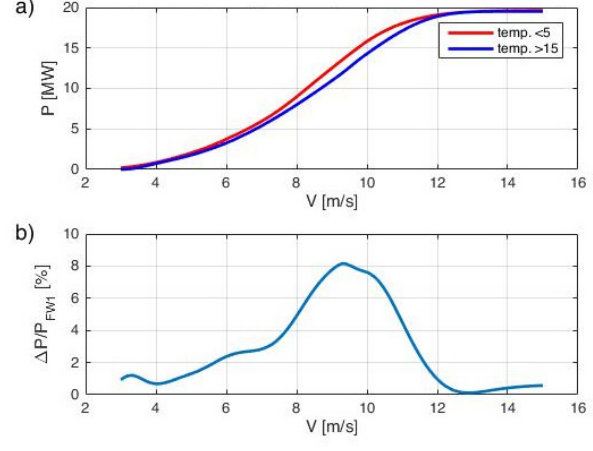
Figure 8. Wind power plant FW1: ( a ) power characteristics for T < 5 ◦ C i T > 15 ◦ C determined using neural networks, ( b ) power plant power difference for both cases as percentage of the farm’s rated output.